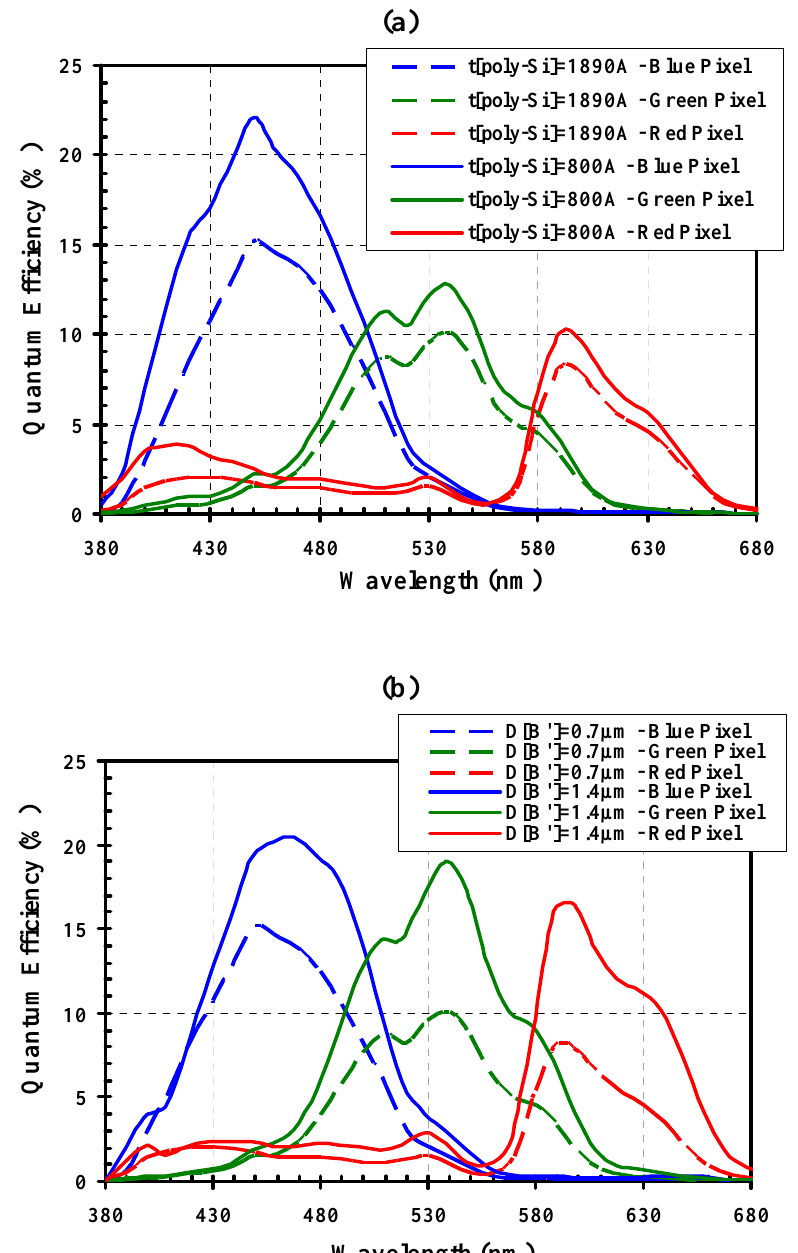
Figure 10. Simulated results on the pixel quantum efficiency (with color filters) for: (a) a = 800 Å (solid curves) compared to t poly-gate t poly-si charge-collecting region centered at depth D µm (dash